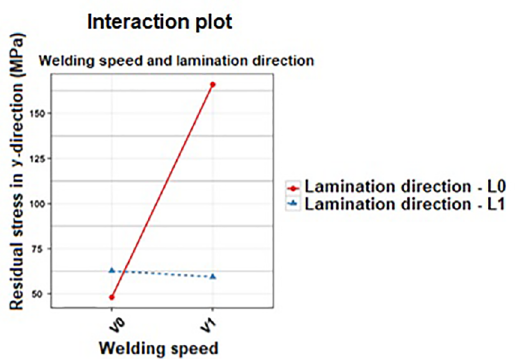
Figure 6. Graph of interactions of welding speed and lamination direction in the residual stress in